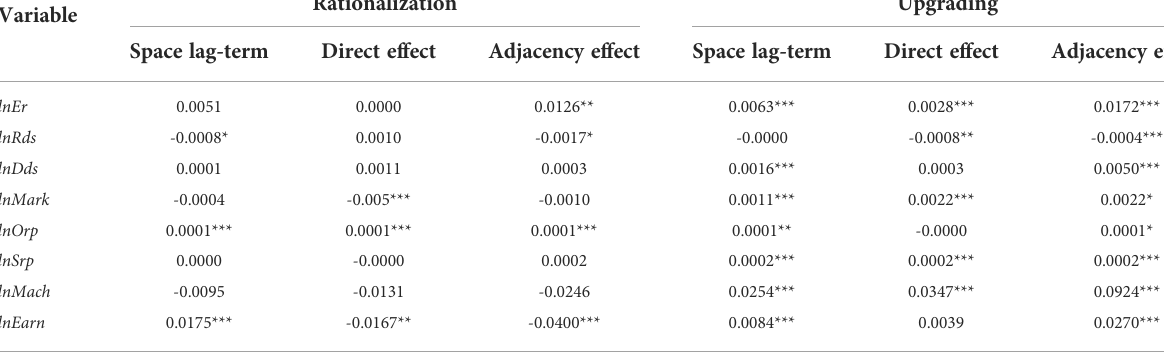
TABLE 6 Spatial Durbin model direct effect and adjacency effect decomposition.